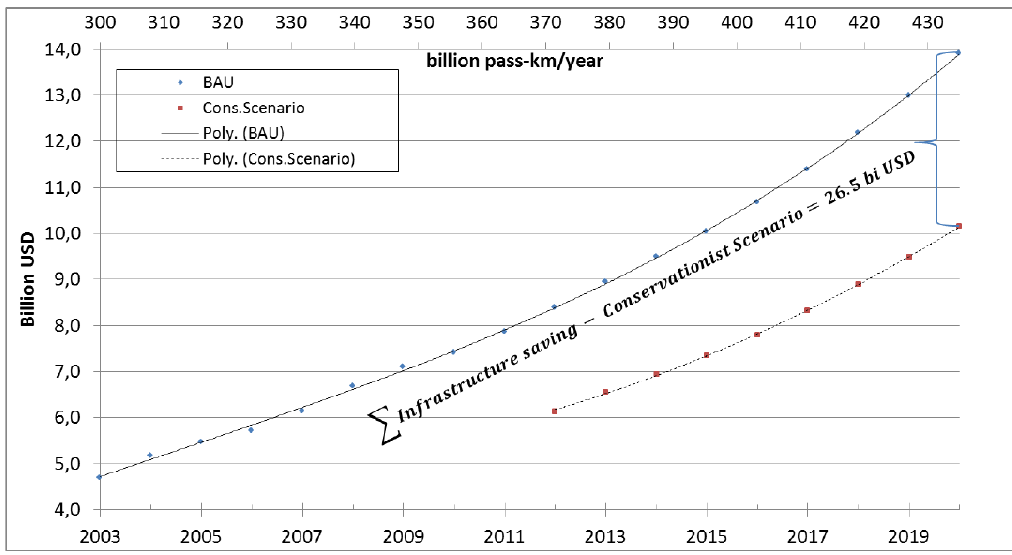
Figure 13. Costs of Infrastructure